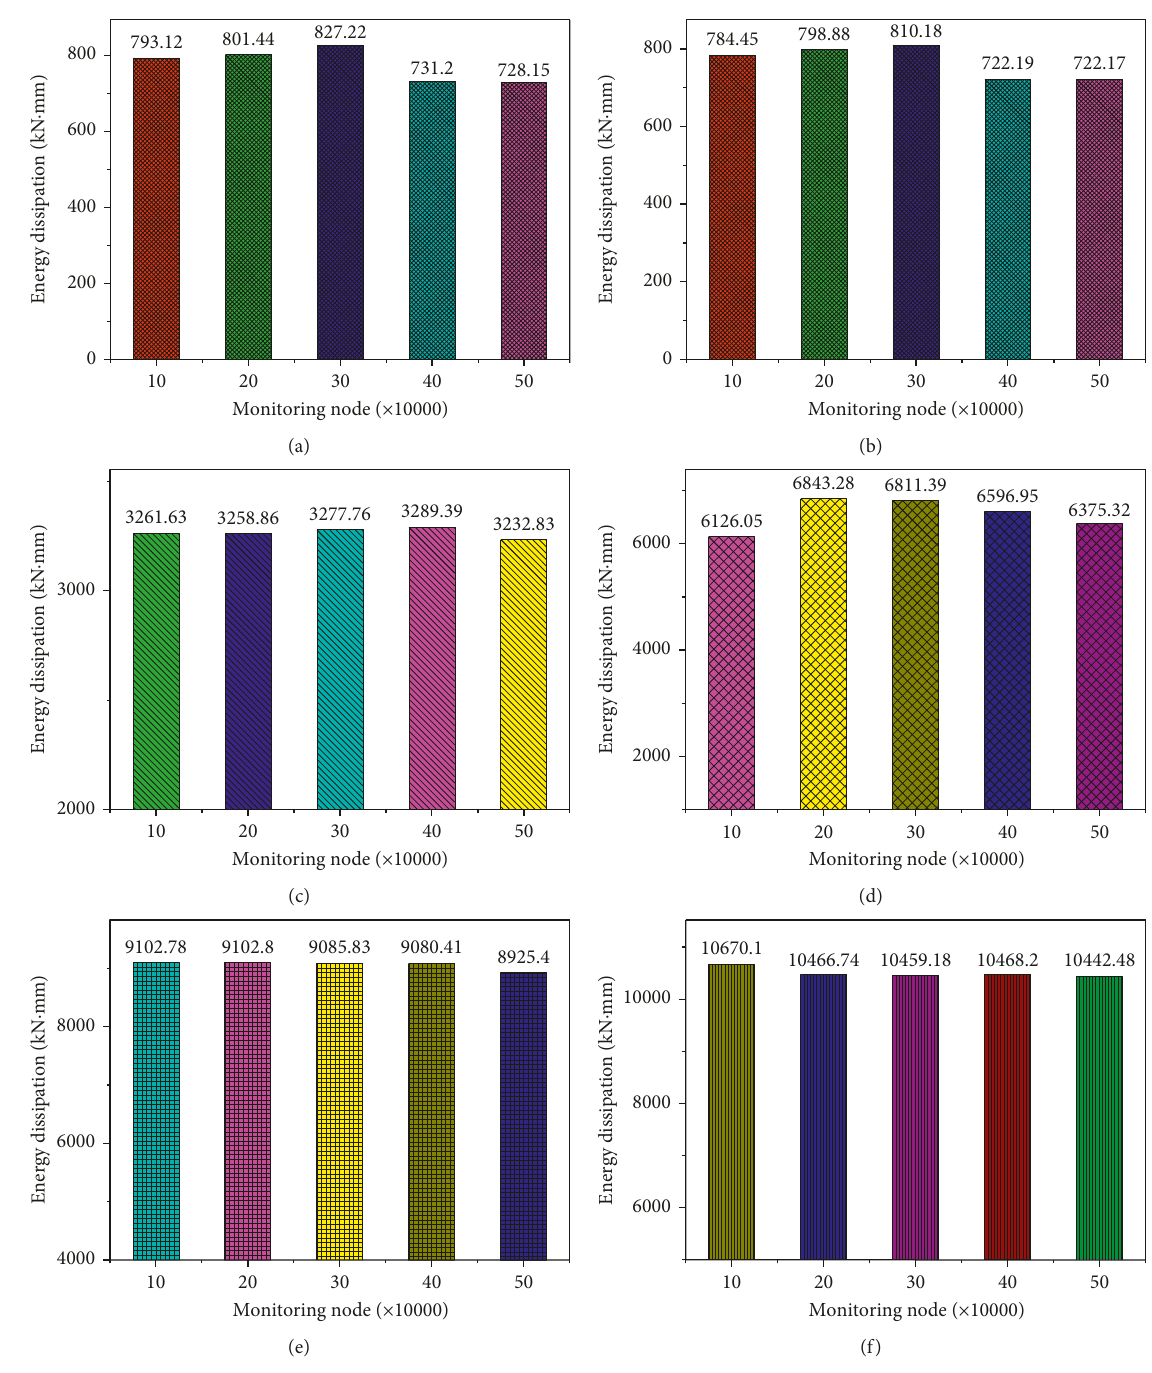
Figure 5: Energy dissipation analysis: (a) GZ-1; (b) GZ-2; (c) GZ-3; (d) GZ-4; (e) GZ-5; (f)